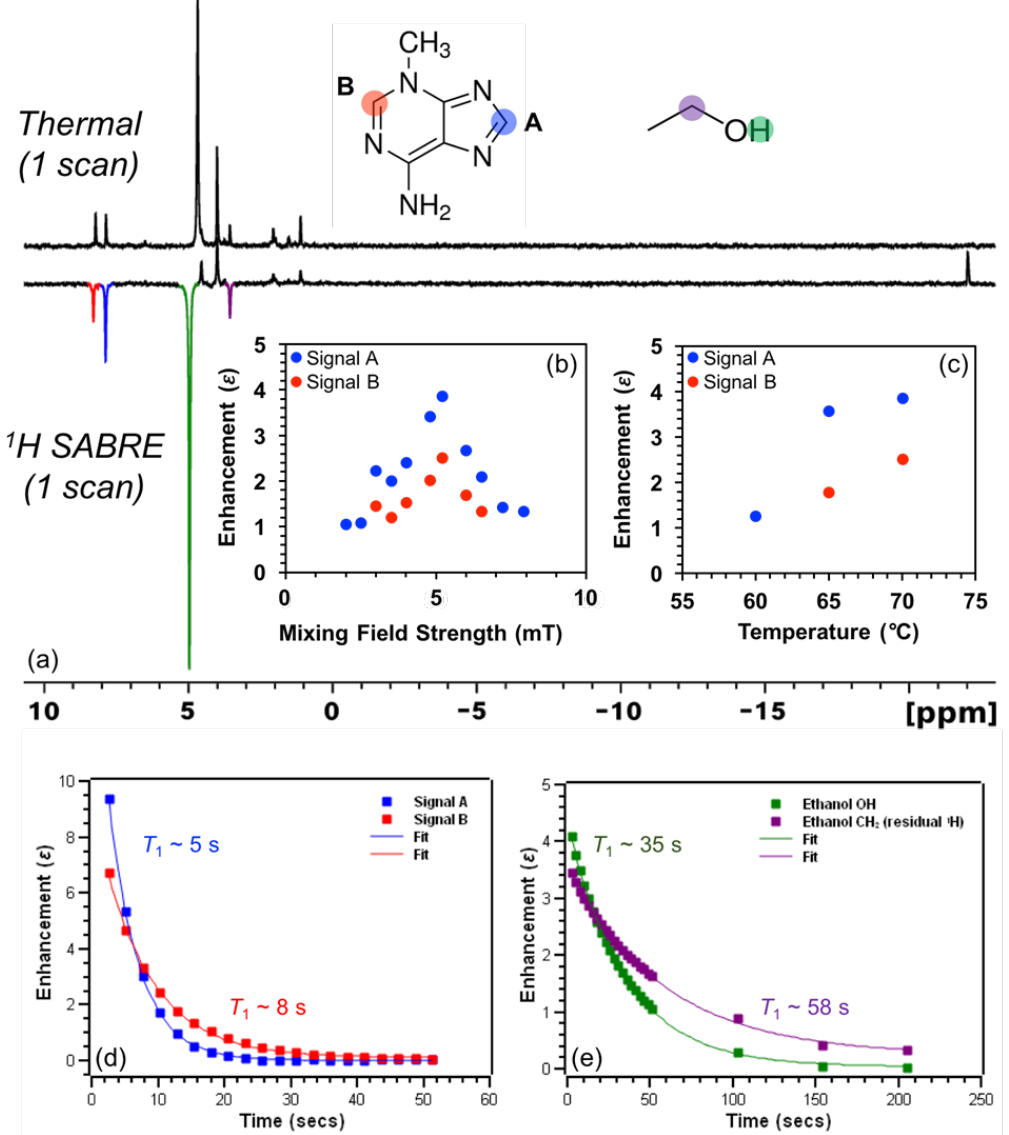
Figure 4. ( a ) 1 H NMR thermal ( top ) and SABRE enhanced ( bottom ) spectra of 3-methyl adenine at 70 °C show differential enhancement (and presumptive preferential binding) of the imidazole ring with a maximum ε of ~(-)4 at ( b ) ~5.2 mT and ( c ) 70 °C. HP 1 H signals of 3-methyladenine exhibit T 1 time constants ( d ) of ~5 s ( 1 H A ) and ~8 s ( 1 H B ), whereas HP signals from residual 1 H spins of C 2 D 5 OD solvent molecules decay with T 1 time constants ( e ) of ~35 s (-OH) and ~58 s (-CHD, residual 1 H). Note that the -OH resonance of ethanol shifts due to a reduction of temperature when the solution is bubbled with p -H 2 . T 1 values: in ( d ): 4.52 ± 0.03 (blue); 7.60 ± 0.13 (red); in ( e ): 35.1 ± 0.4 (green); 58.2 ± 1.2 (purple); similar T 1 values were measured at the lower temperatures (not shown).